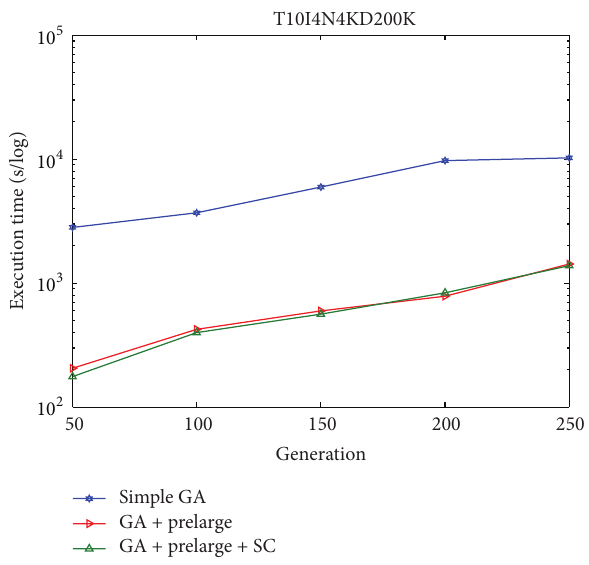
Figure 10: Execution time of the original GA-based algorithm and the GA-based algorithm involved prelarge concept (with and without sliding count) in simulation dataset.